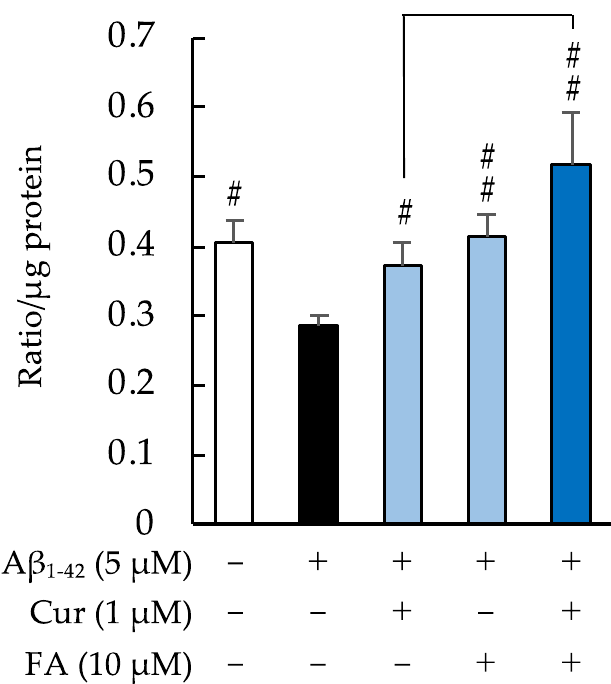
Figure 7. Effect of Cur, FA, or a combination of both on cell membrane fluidity A β 1–42 -stimulated SH-SY5Y cells. The fluidity of cell membrane in A β 1–42 -stimulated SH-SY5Y cells was evaluated us- ing PDA. The fluidity of cell membrane in SH-SY5Y cells exposed to 5 µM Aβ and treated with 1 – 42 Aβ + 1 µM Cur, Aβ + 10 µM FA or Aβ + Cur + FA. In the absence of 5 μM Aβ , membrane 1 – 42 1 – 42 1 – 42 1 – 42 fluidity levels of control, 1 μM Cur, 10 μM FA and Cur + FA -treated cells were 0.41 ± 0.045, 0.38 ± 0.036, 0.42 ± 0.041 and 0.43 ± 0.064 ratio/μg protein ( no significant difference, n = 6, Tukey). +: inclu-